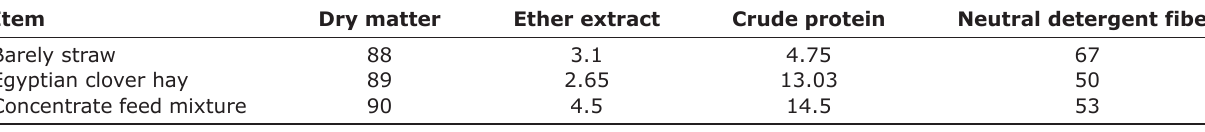
Table-1: The chemical composition (%) of concentrates feed mixture, barley straw, and Egyptian clover hay.